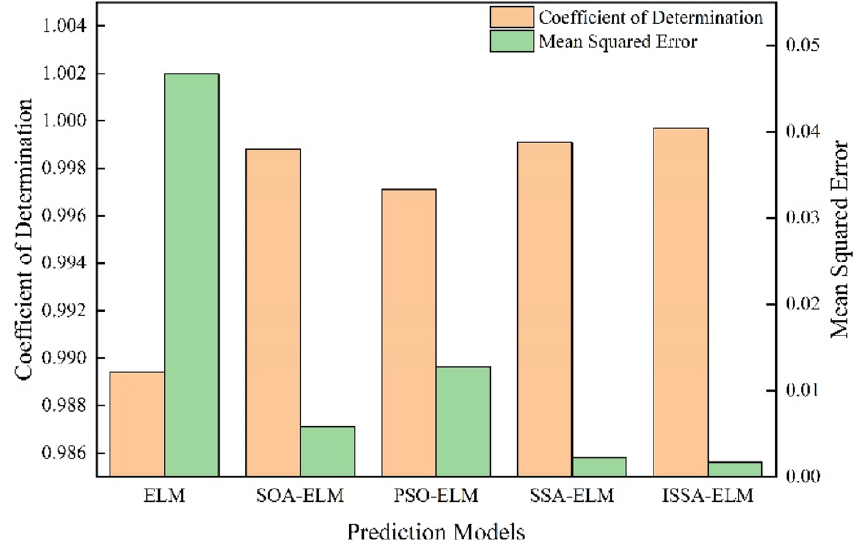
Figure 7. Comparing the mean squared errors and coefficients of determination of the different models.